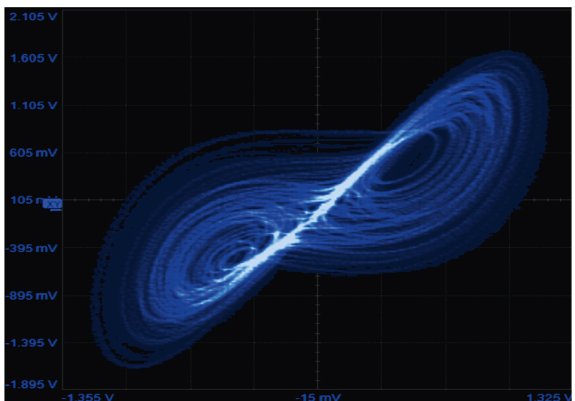
Figure 36: Experimental hyperchaotic attractor of the proposed model (1) in the ( z